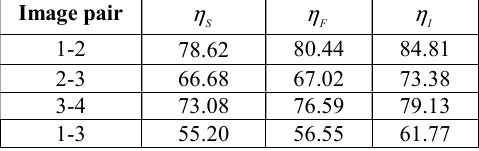
Table 5. Percentage Overlap Values for 55° Corner Results in Tables 2, 3, 4 and 5 confirm that the image footprint size and overlap fractions for convergent images vary according to camera positions. In Tables 2 and 3, the difference of